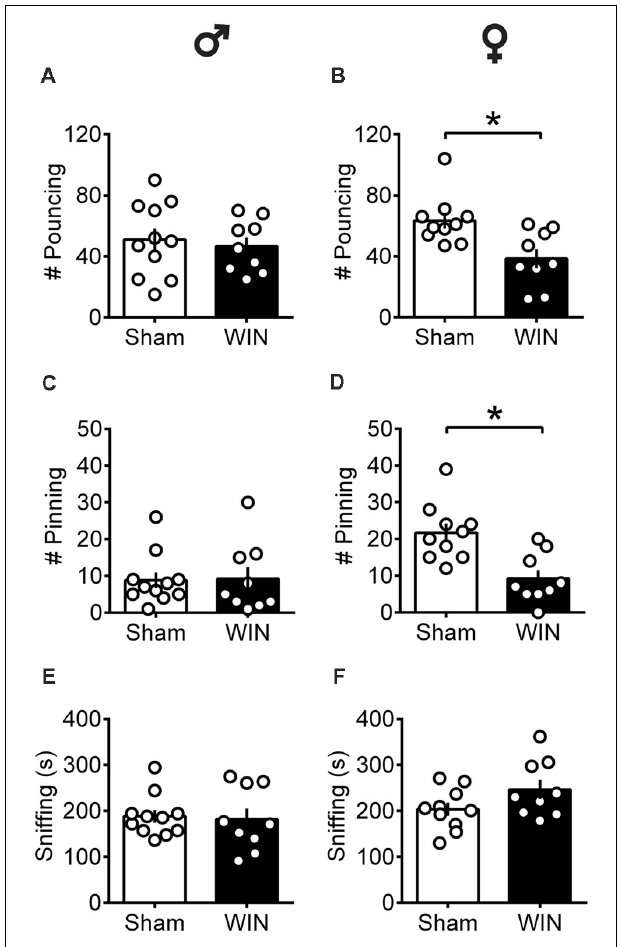
FIGURE 1 | Sex-specific alteration of play behavior in pubescent rats 24 h after a single in vivo cannabinoid exposure. Twenty-four hours following a single exposure to WIN55,212-2 (WIN, 2 mg/kg, s.c.), pouncing was normal in male pubescent rats (A) in contrast to female littermates (B) whom displayed a marked reduction in the number of pouncing compared to Sham animals. Twenty-four hours following WIN exposure, pinning was similar to that of Sham animals in males (C) but was largely reduced in female littermates (D) . WIN-exposed rats of both sexes ( E , Male; F , Female) spent similar time sniffing the congener compared to their respective Sham groups. Data represent mean ± SEM. Scatter dot plot represents a pair of animals.